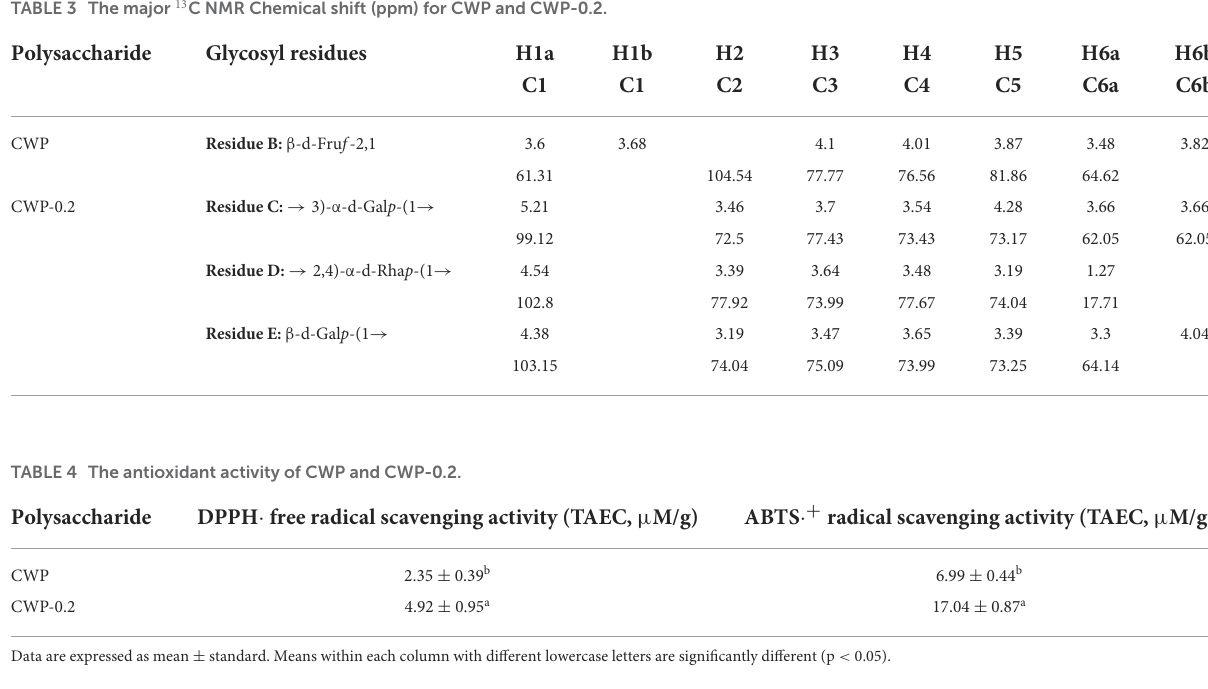
CWP ResidueB: β -d-Fru f -2,1